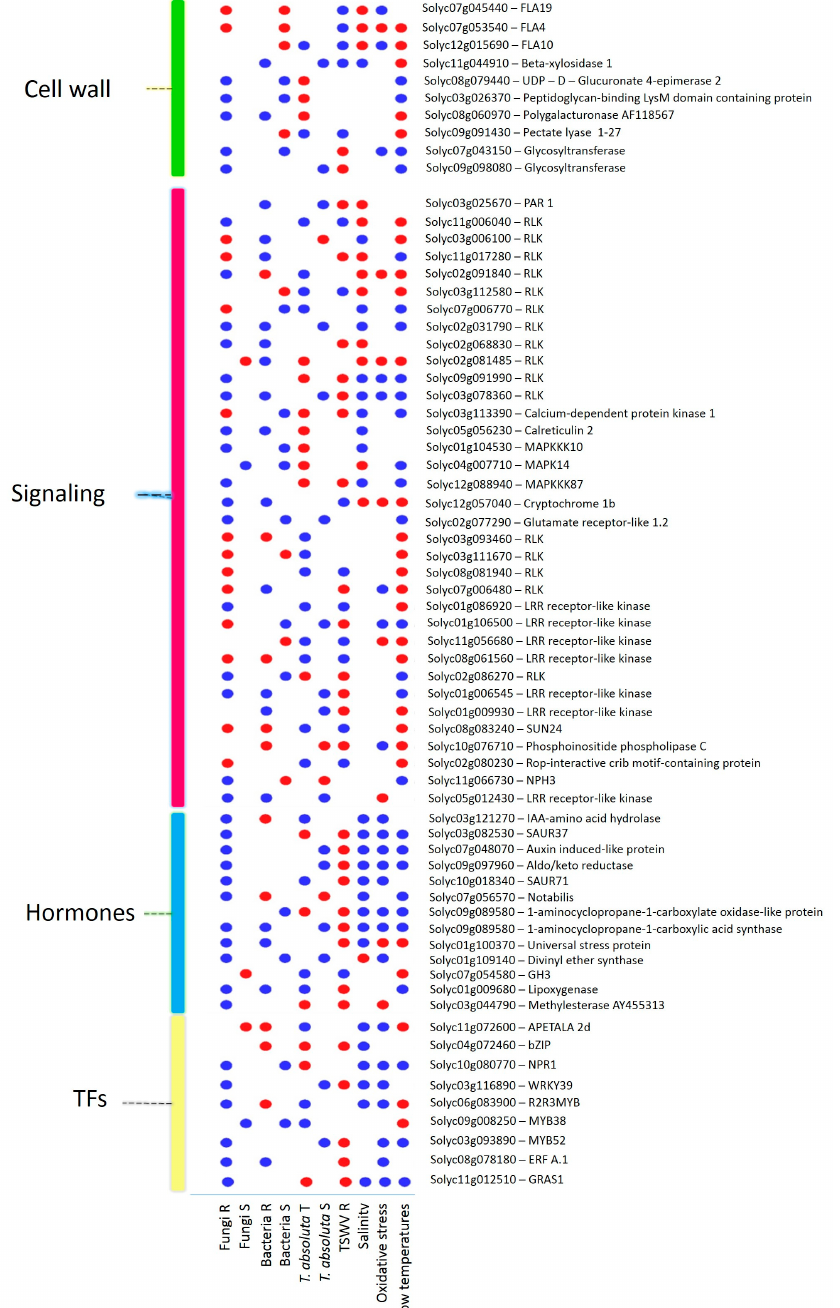
Figure 9. DEGs responsive to biotic and abiotic stresses, encoding for cell wall precursors, signaling proteins, hormones, and TFs. Blue = upregulated; red = downregulated genes. R = resistant; S = susceptible; T = tolerant